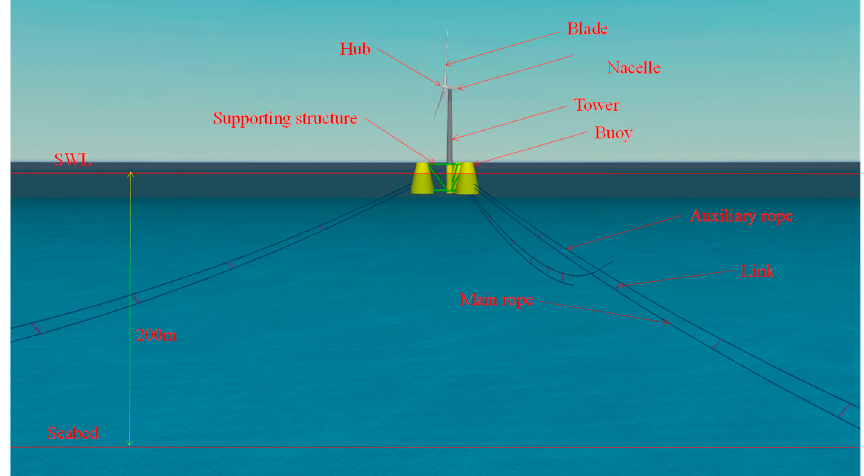
Figure 3. Model of floating wind turbine with double-rope mooring system.